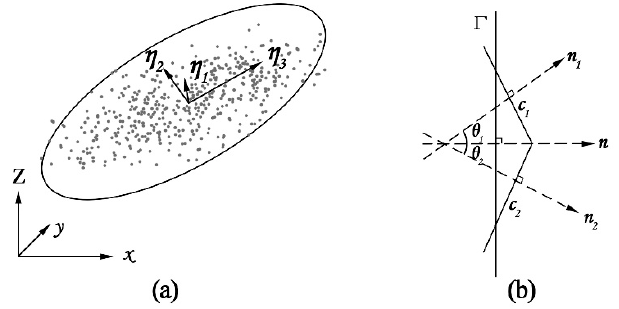
Figure 4. Constraints used during region growing of the support region. ( a ) Planarity constraint determined from the spectral features. ( b ) Angle deviation in the supervoxels.